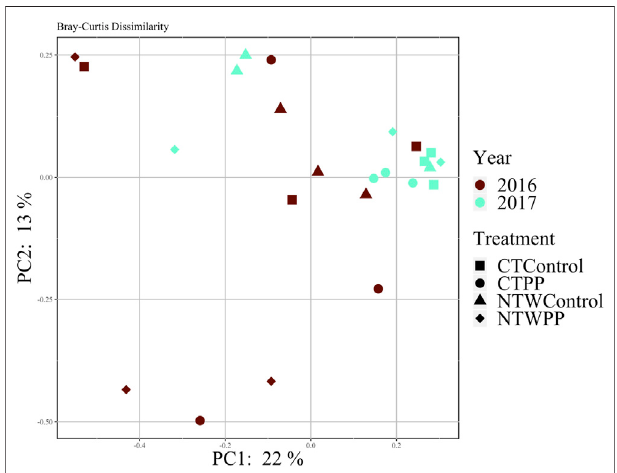
FIGURE 3 | Bray-Curtis dissimilarity of microbial communities in 2016 and 2017. CT, conventional tillage; NTW, no-tillage with winter wheat cover crop; PP, pre-plant N application; Control, no-added N fertilizer.